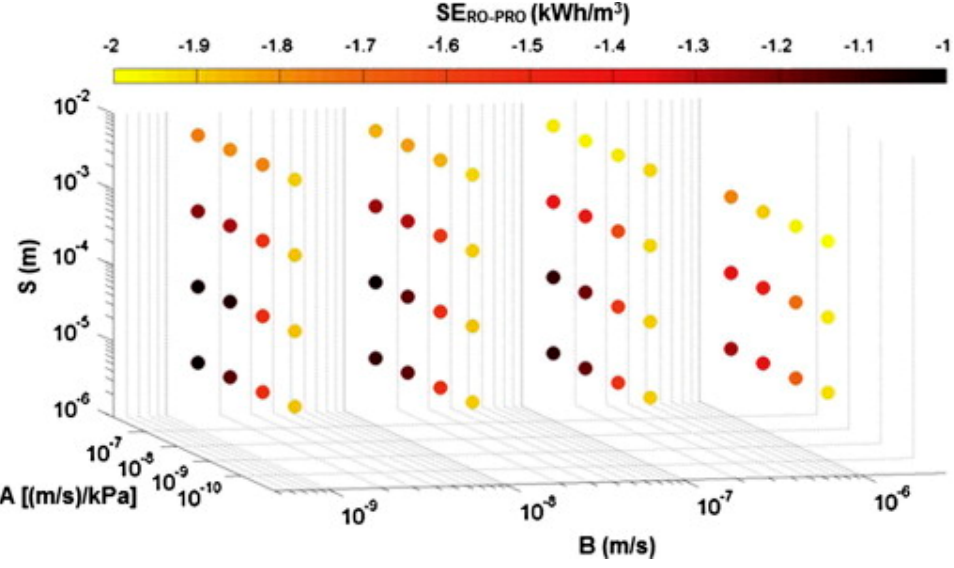
Figure 12. The results of sensitivity analysis of an RO-PRO hybridized process using 64 virtual membranes. In this figure, Rec RO = 50%, and C F , b , RO = 35,000 ppm [65]. The figure is reproduced from Reference [65] with permission.